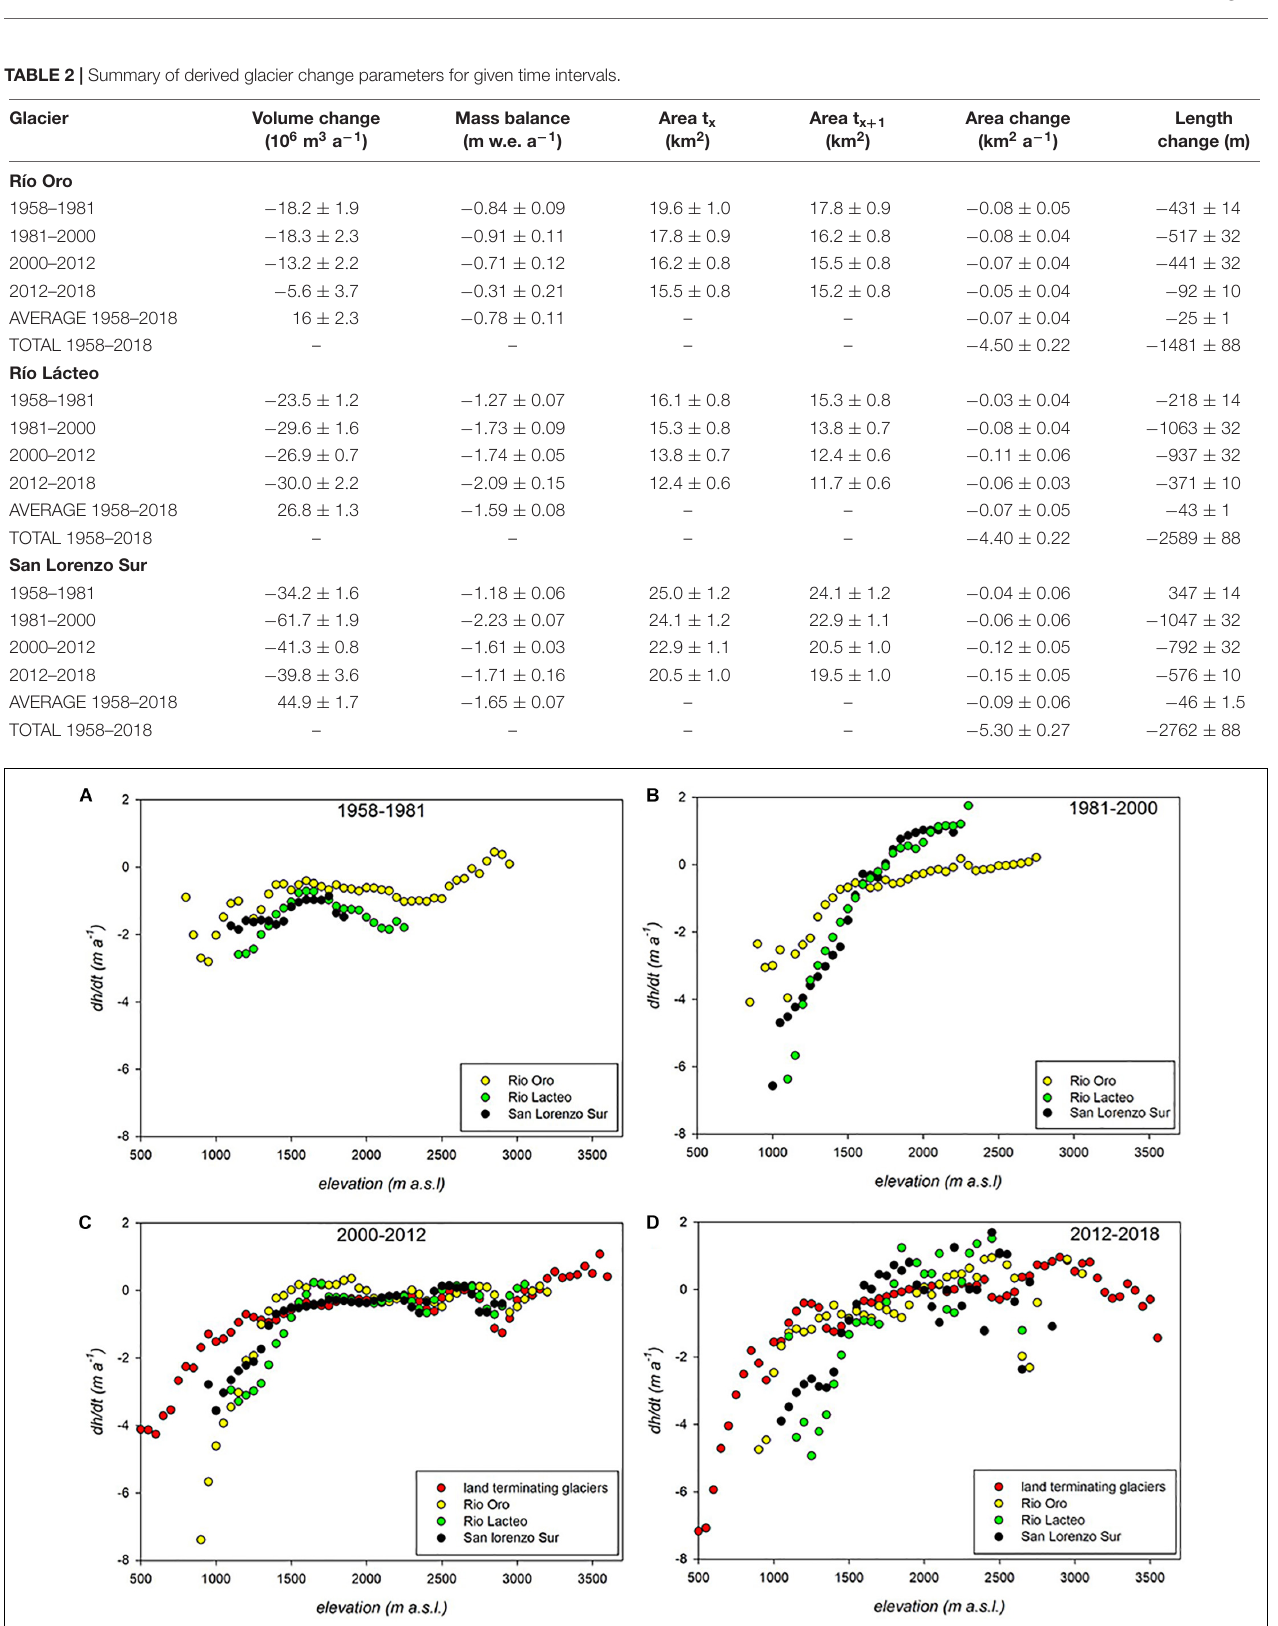
FIGURE 5 | Scatter plot showing glacier elevation change rates as a function of elevation for individual time periods (A–D) .